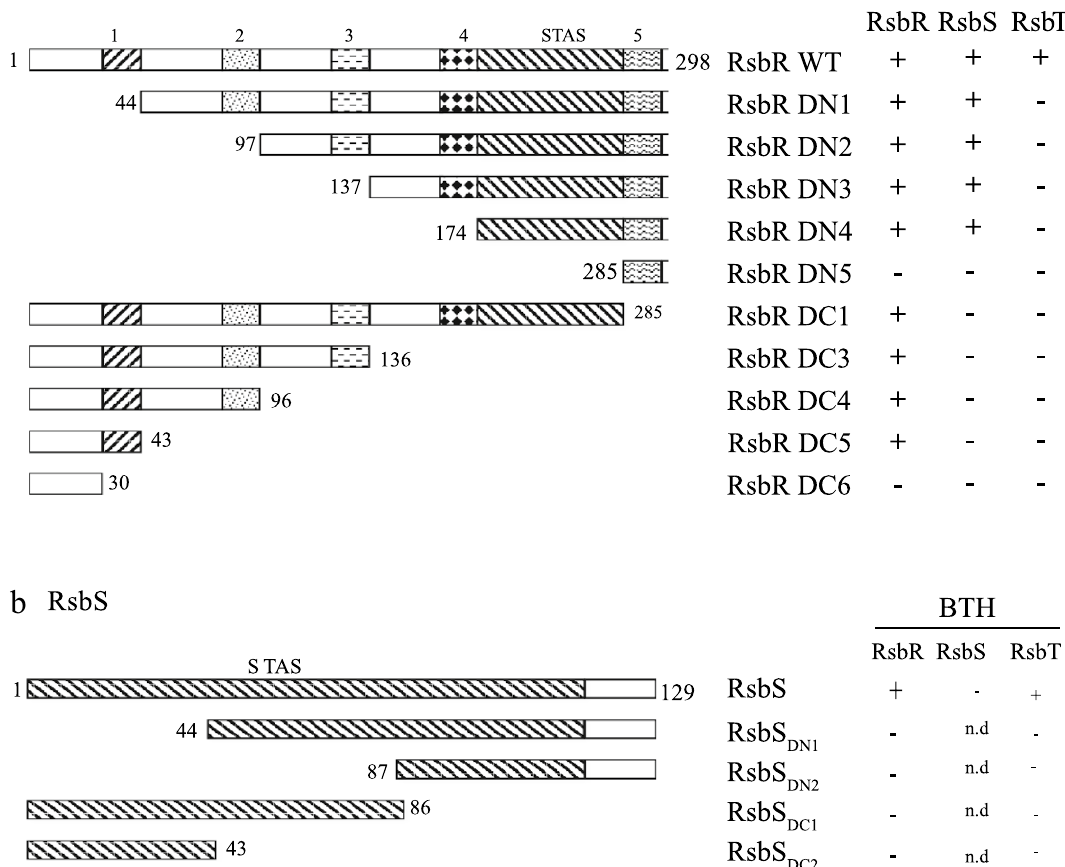
Figure 1. Schematic representation of domains of RsbR and RsbS proteins and design of several deletions along with the protein–protein interaction results of the bacterial two-hybrid (BTH/BACTH) assay. ( a ) The RsbR protein (298 amino acids long) contains a C terminal "STAS" domain (amino acids 174–285) and five (numbered 1 to 5) major coiled-coil (CC) regions distributed along the polypeptide as revealed using the "coils" tool available on Expasy. The amino acid numbers for start and end of ‘CC’ regions are as follows: 1. 30–43; 2. 83–96; 3. 123–136; 4. 159–173; 5. 275–289. Several RsbR deletions (names are given on the right-hand side of every scheme) are also shown along with their BTH (BACTH) interaction results with RsbR, RsbS and RsbT proteins. DN and DC refer to deletion at the N- and C-terminals, respectively. ( b ) The RsbS protein (129 amino acids long) mostly consists of a "STAS" domain (first 112 amino acids). The deletion scheme shows progressive 43 amino acids deletion either from N terminus (RsbS DN1 and RsbS DN2 ) or from the C terminus (RsbS DC1 and RsbS DC2 ). Right panel shows a summary of the BTH (BACTH) results. Note that full length RsbS is required for its interaction with RsbR and RsbT. In both panels A and B, plus and minus signs refers to interaction or no interaction based on Fig. S4. For details see main